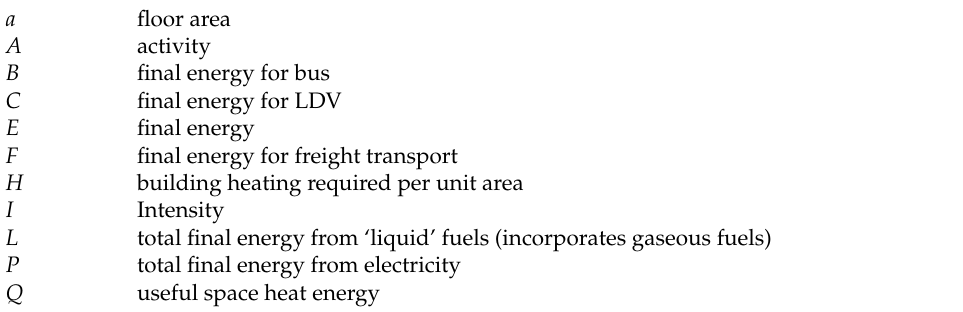
Table A1. Nomenclature for Appendices.